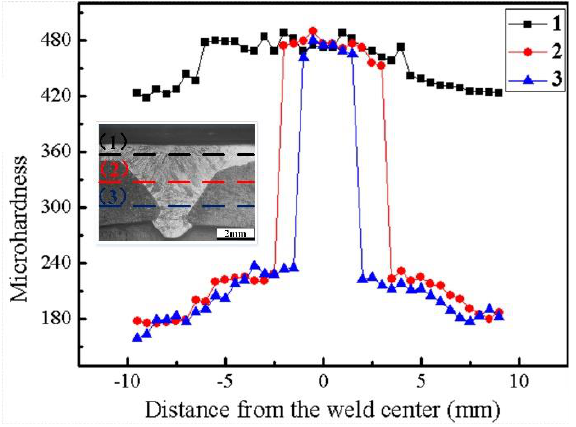
Figure 14. Microhardness distribution across the weld.